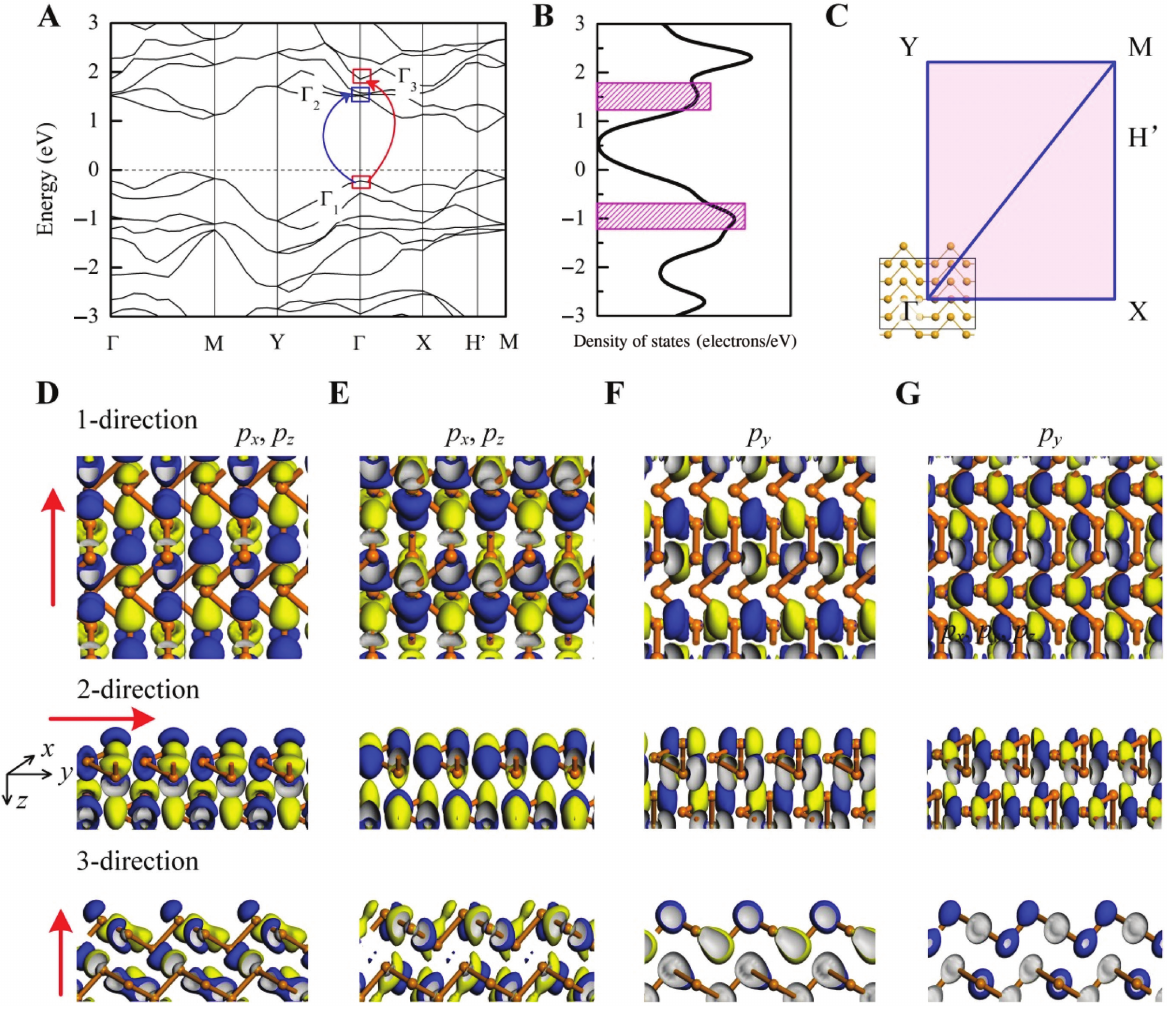
Figure 6: TD-DFT resolved anisotropy in electron transitions of bilayer telurene. (A) The band structure of bilayer tellurene. The blue and red arrows in (A) indicate the electron transitions from Γ Total density of states of bilayer tellurene. The shadow areas denote the peaks of DOS. (C) The Brillouin zones of the bilayer tellurene. The top, side, and top views of contributing molecular orbitals at the (D) HOMO, (E) LUMO, (F) HOMO-1, and (G) LUMO + 3 energy bands. Axes x , y , and z define the directions of p orbitals. Red arrows indicate the electron transport